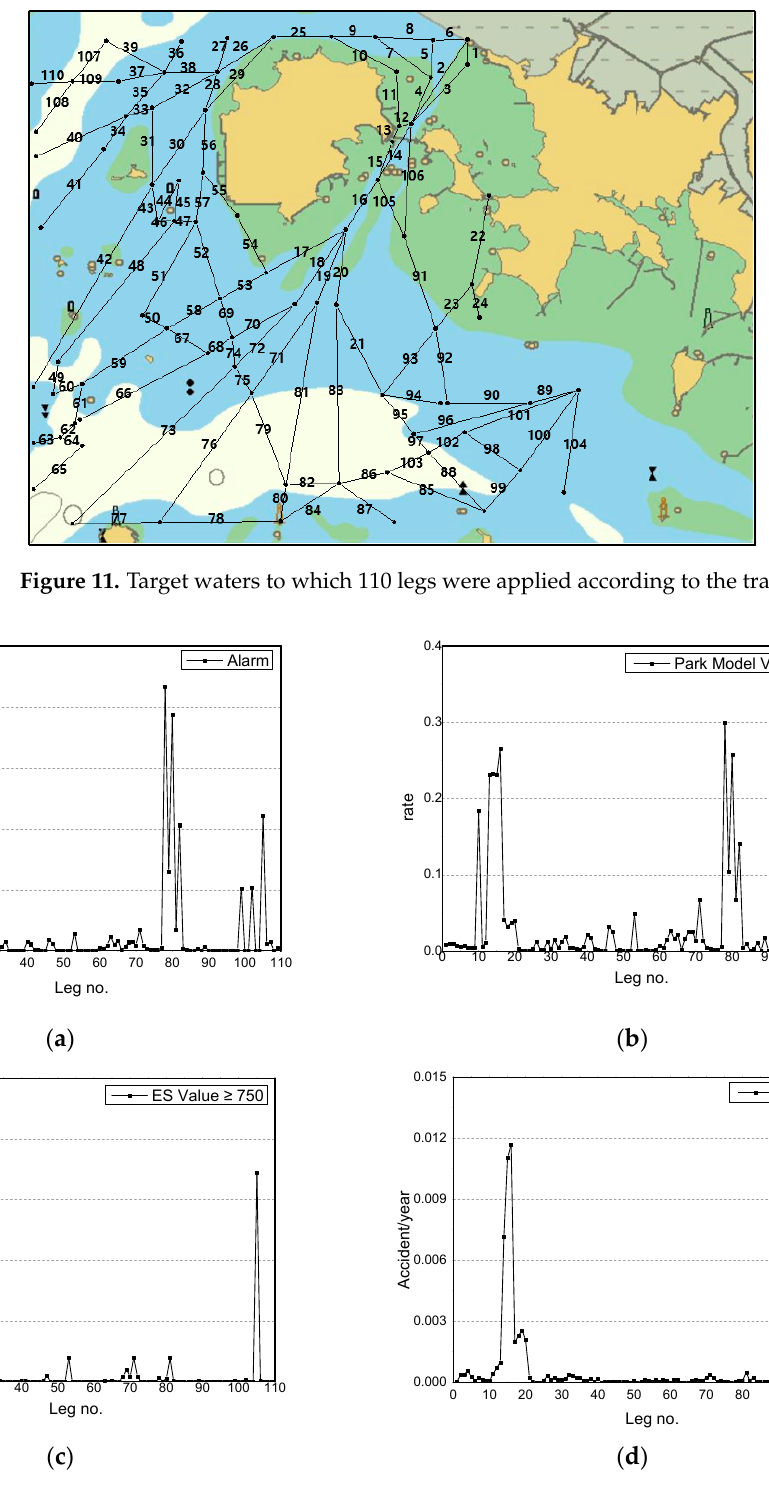
Figure 12. ( a ) Graph of the alarm generation ratio depending on the number of legs, ( b ) graph of the ratio of PARK model risk value at or over five depending on the number of legs, ( c ) graph of the ratio of ES value at or over 750 depending on the number of legs, and ( d ) graph of the yearly collision estimation frequency depending on the number of legs.